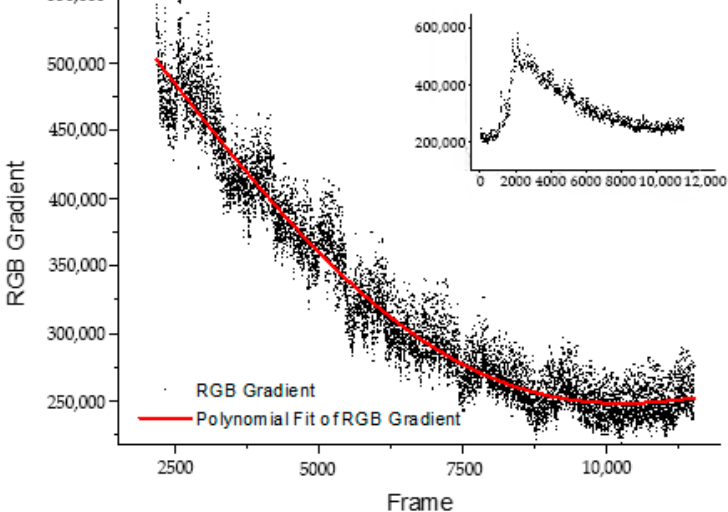
Figure 3. The end data fitting under 100 rpm stirring, among which the inset image is the variation of RGB color gradient with time in a beaker under 100 rpm stirring.